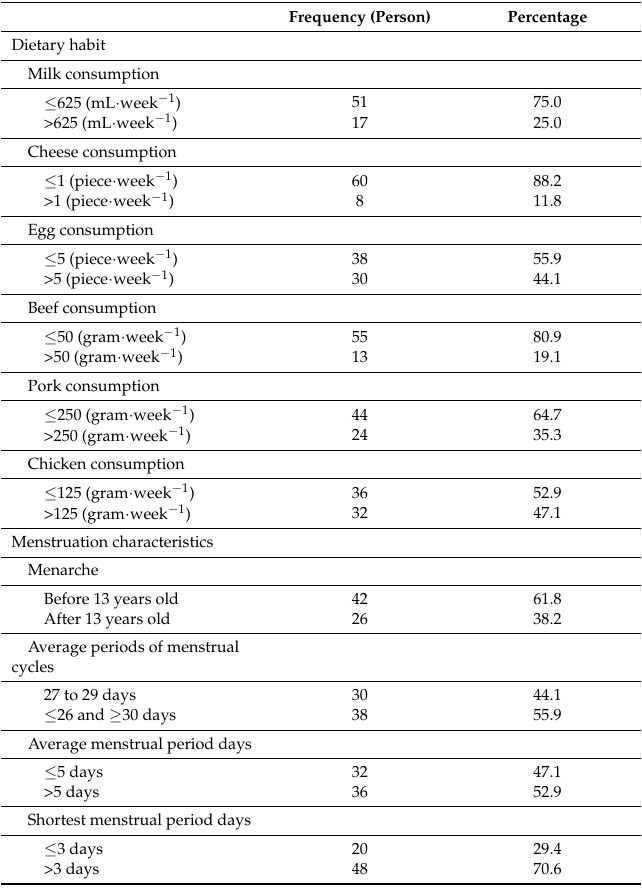
Table 2. Descriptive statistics of dietary habit and menstruation characteristics in the pregnant women ( n =